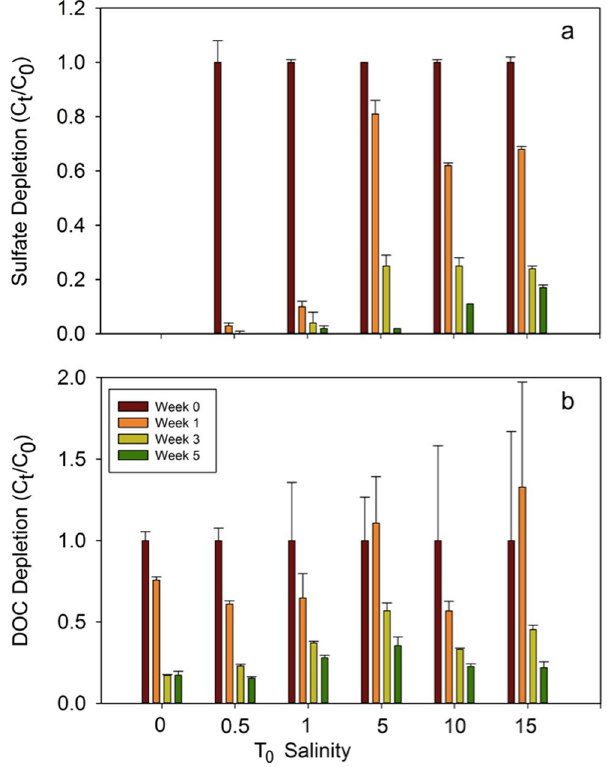
Figure 1. Changes in sulfate ( a ) and DOC ( b ) concentrations relative to initial concentration over a 5 week dark and anaerobic incubation period. Initial sulfate concentrations were equivalent to salinity * 0–15 and DOC concentrations are a combination of background DOC and acetate added in stoichiometric proportions to sulfate. Error bars represent standard